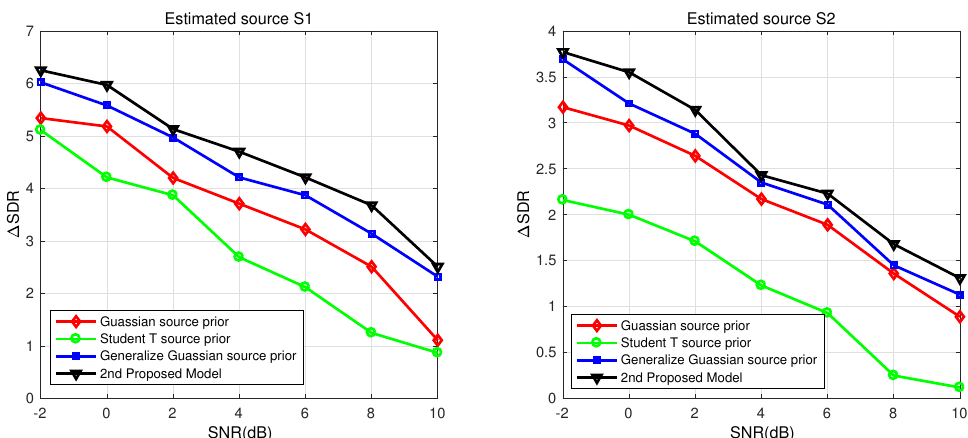
Figure 4. Change in SDR for convolutive pink noisy mixture with variable SNR for the 2nd proposed model.